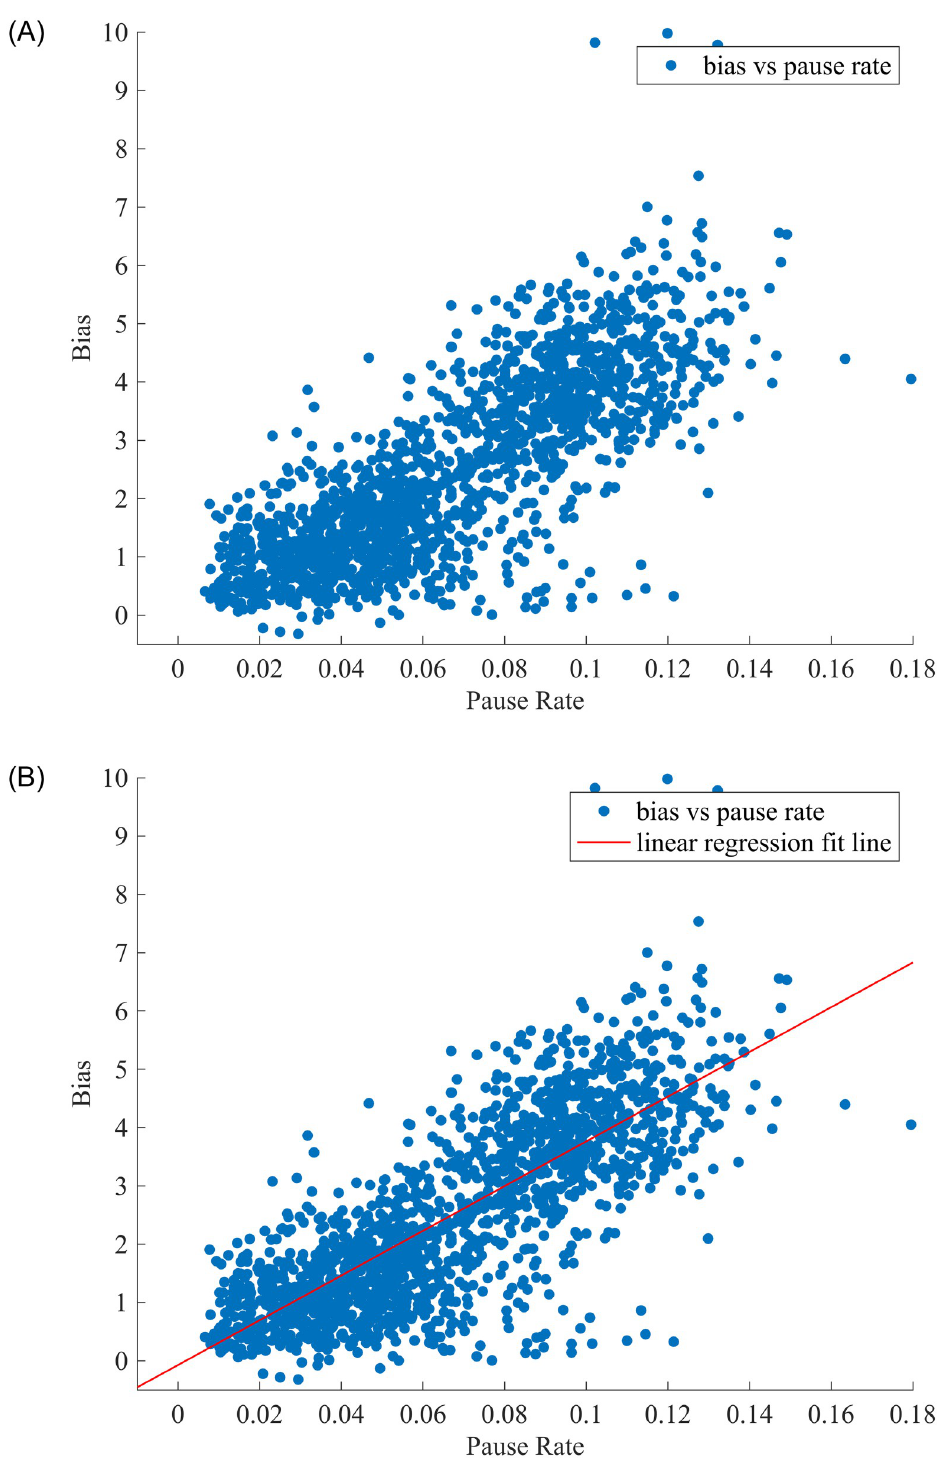
Fig 11. Scatterplot of bias versus pause rate and the regression line. A: Scatterplot of bias versus pause rate. B: Regression line.